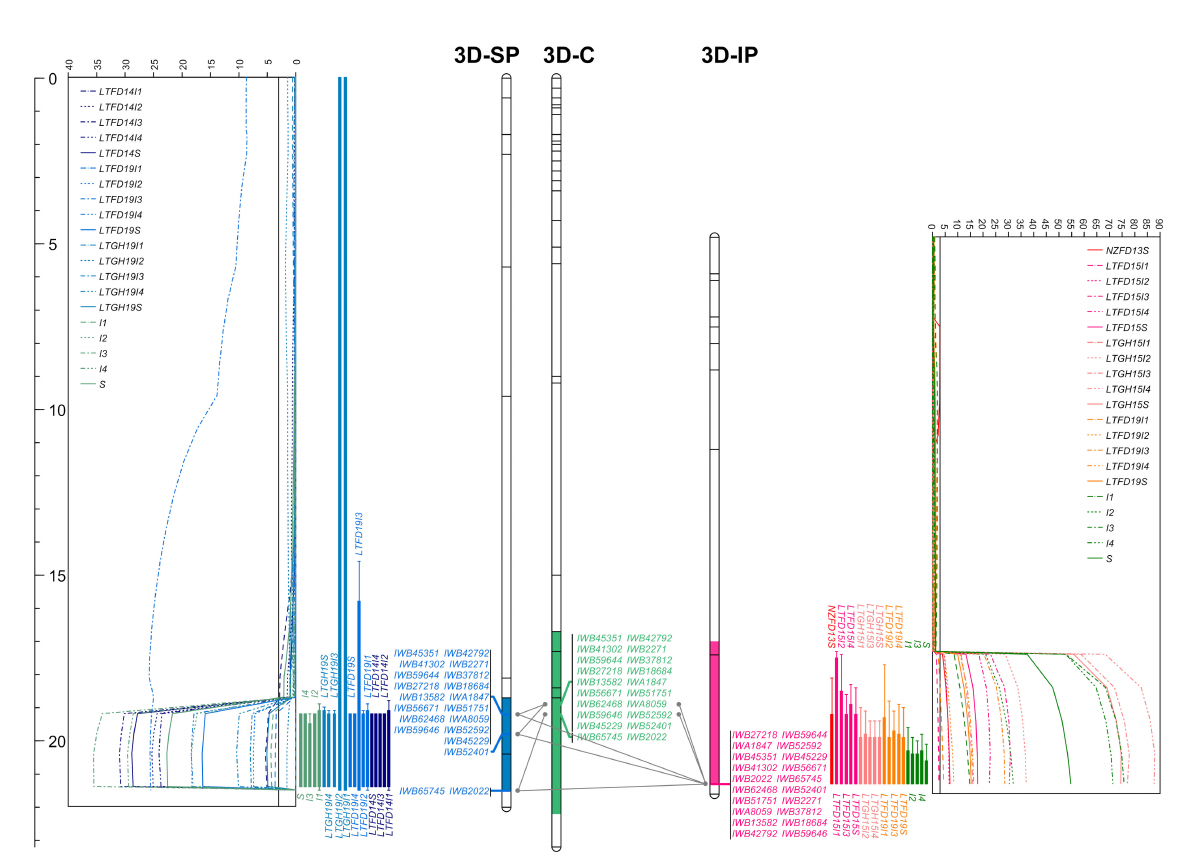
FIGURE 7 The linkage maps of chromosome 3D deciphering the logarithm of odds (LOD) curve plots for major solidness (stem, S and internode, I) quantitative trait locus (QTL) QSst.lrdc-3D detected using composite interval mapping from ‘ Sadash/P2711 ’ (3D-SP) and ‘ AAC Innova/P2711 ’ (3D- IP) doubled haploid populations in each of the trial environments and pooled data along with a chromosome 3D consensus map (3D-C) in middle. Positions of markers are shown as lines on linkage group bars and a scale in cM on the left of the graph. SNP markers common between the two linkage groups and the consensus map are shown by SNP IDs in green font, while markers common between a population map and the consensus map are shown in blue (for ‘ Sadash/P2711 ’ markers) or dark pink (for ‘ AAC Innova/P2711 ’ markers) color. Relationships among linkage groups and consensus map are shown using gray color connections for each common marker. QTL intervals are shown using a different colored segment of linkage group bars, while QTL con fi dence intervals for each environment/trait combination are shown using different colored bars against LOD curve plots. LTFD14(I1-I4, and S), LTFD19(I1-I4, and S), LTGH19(I1-I4, and S), and single letter (and numerals) I1 to I4 and S represent QTL detected in fi eld experiments in 2014, 2019, greenhouse experiment in 2019 and pooled data obtained from Lethbridge, Alberta location for whole stem and culm internodes I1 (uppermost) to I4 (lowermost) ratings of doubled haploid lines of ‘ Sadash/ P2711 ’ population. Similarly, NZFD13S, LTFD15(I1-I4, and S), LTGH15(I1-I4, and S), LTFD19(I1-I4, and S), and single letters (and numerals) I1 to I4 and S represent QTL detected in fi eld experiments in New Zealand in 2013, Lethbridge fi eld trials in 2015, Lethbridge greenhouse experiments in 2015, Lethbridge fi eld trial in 2019 and pooled data obtained from Lethbridge, Alberta location for the whole stem and culm internodes I1 (uppermost) to I4 (lowermost) ratings of doubled haploid lines of ‘ AAC Innova/P2711 ’ population. Straight lines across the LOD plot represent the LOD signi fi cance